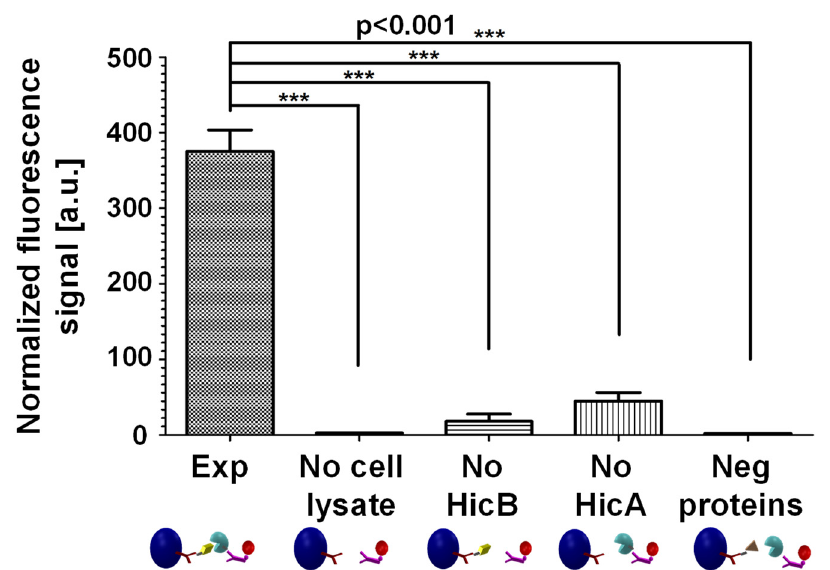
Figure 8. Identification of a novel toxin antitoxin pair, HicA and HicB, in Pseudomonas aeruginosa . Abbreviations: “Exp”, the experiment with cell lysate of Pseudomonas aeruginosa ( P. aeruginosa ) overexpressing HicA and HicB. “No cell lysate”, the same experiment without cell lysate. “No HicB”, the same experiment with cell lysate of P. aeruginosa overexpressing HicA solely. “No HicA”, the same experiment with cell lysate of P. aeruginosa overexpressing HicB solely. “Neg proteins”, the same experiment with cell lysate of P. aeruginosa overexpressing two proteins that are not known to interact with one another (SadB and ParD). Three asterisks (***) indicate a statistical significance of p < 0.001. Reprinted from [16], Copyright (2020), with permission from